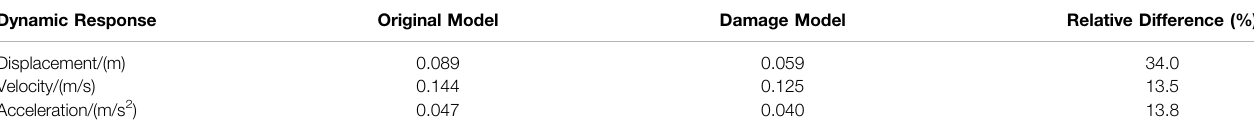
TABLE 5 | Maximum dynamic response original model and damage model of simply supported